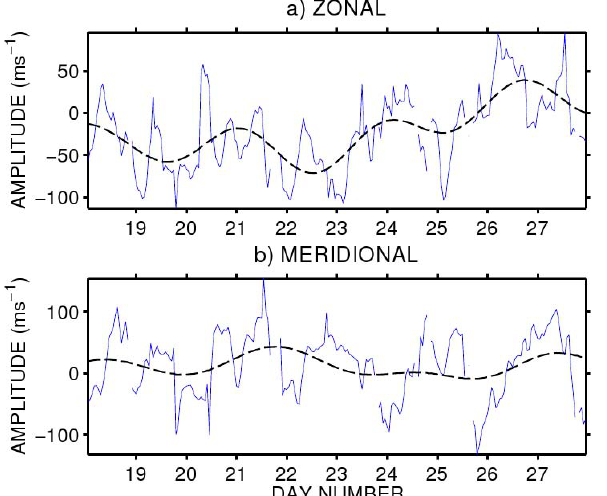
Fig. 1. Raw hourly (a) zonal and (b) meridional winds at a height of 96km from the Ascension Island radar with low-pass filtered winds overlaid (dashed line) for the period 18–28 January 2005. The cut- off of the filter is 2.5 days. Note the oscillations in the zonal winds with period near 3 days.